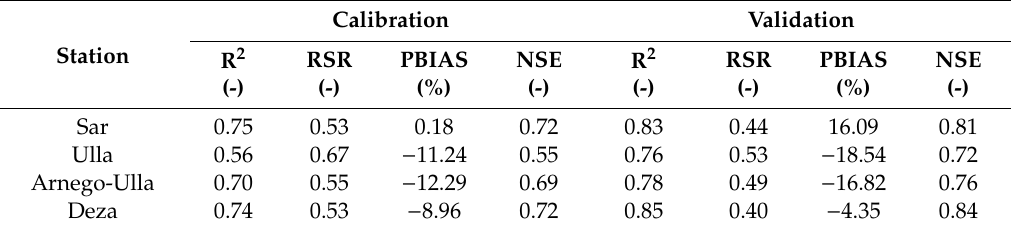
PBIAS, percent bias; NSE, Nash Sutcliffe efficiency.